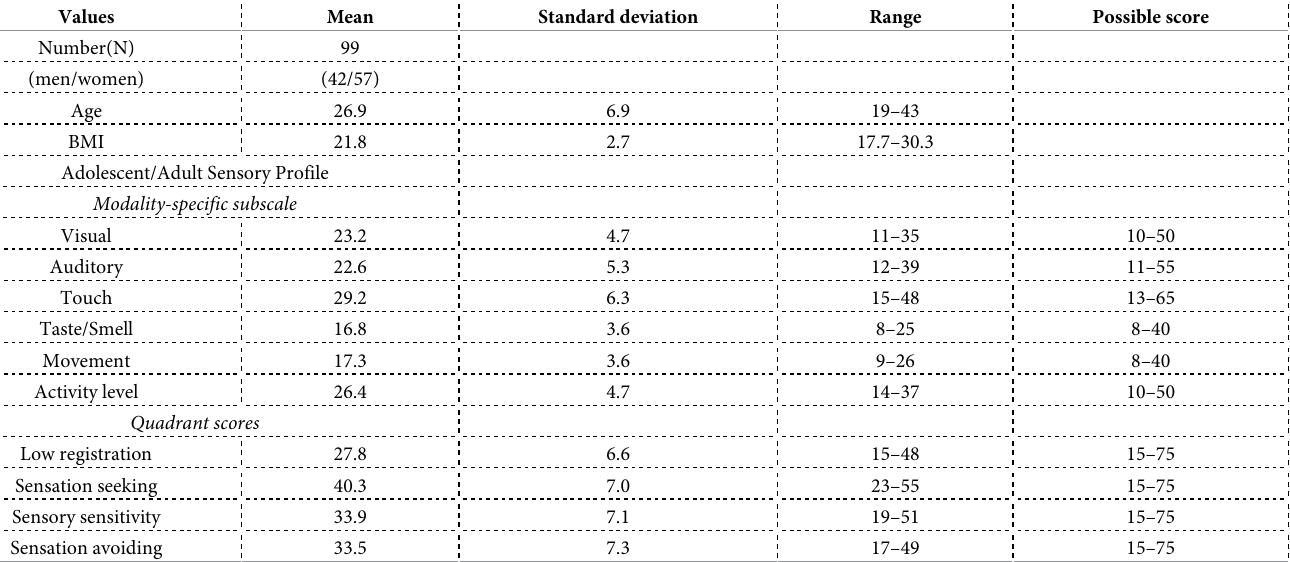
Table 1. Demographic